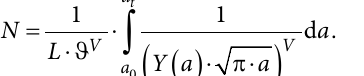
Figure 1. Downtime and costs vs inspection intervals